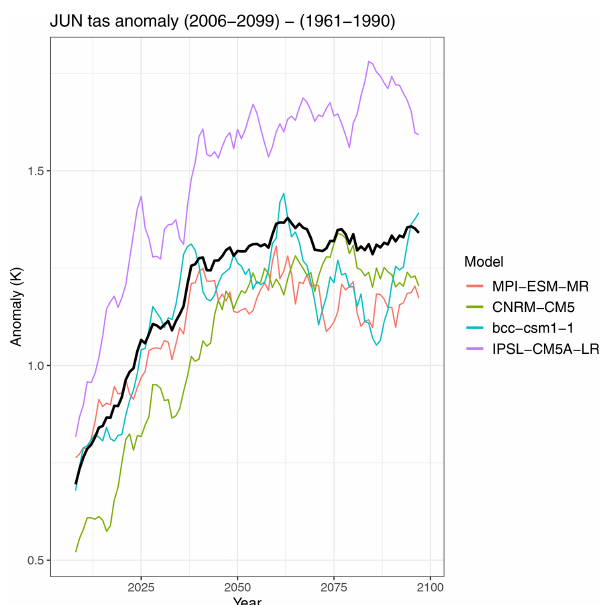
Figure 2. Time series of global average near-surface air temper- ature anomalies in June for the period of 2006–2099 (RCP2.6 scenario) compared to the reference period of 1961–1990. The individual models are shown as colored lines; the multi- model mean is shown in black. See Sect. 3.1 for details on recipe_multimodel_products.yml .